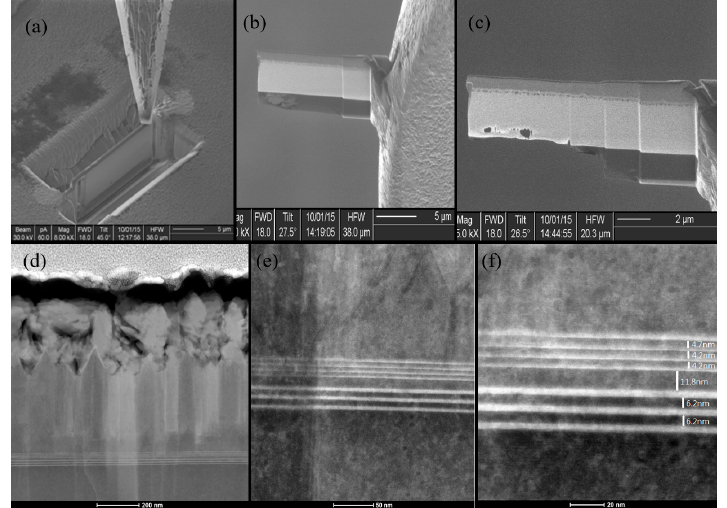
Figure 2. ( a ) FIB ‐ TEM sample preparation, selective area, and deposit Pt bar; ( b ) After FIB etching, using a W needle to lift out the section; ( c ) Thin FIB sample section mounted on a TEM sample grid and further thinning and polishing of the processed section; ( d ) An overall STEM image at low magnification, QD/QW structures are about 800 nm deep to the surface; ( e , f ) The STEM images at high magnification with four QD structures on top and three QW layers at the bottom are clearly observed.